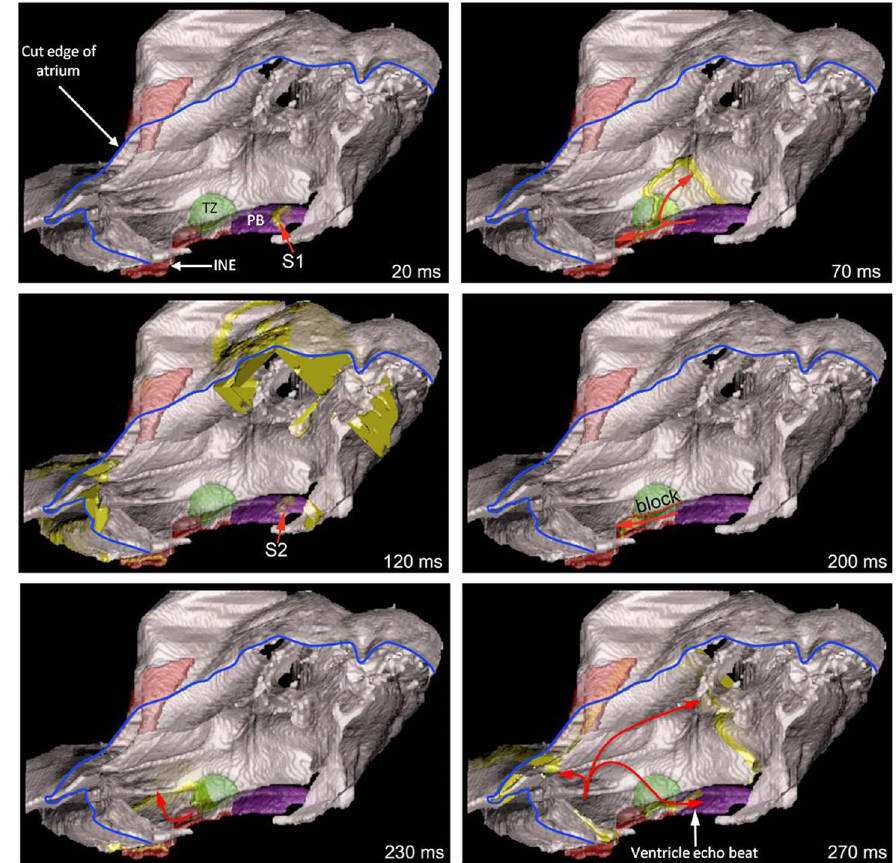
Figure 9. Simulation of a ventricular echo beat. A right view of the model of the right atrium is shown with one face of the right atrium removed (the blue line shows the cut edge of the right atrium). Different segmented structures are shown in different colours. The panels show snapshots of activation after S1–S2 stimulation of the penetrating bundle. The thick yellow lines show the advancing wavefront of activation. The arrows show the direction of action potential conduction. 20 ms, retrograde conduction of the action potential along the penetrating bundle following S1 stimulation. 70 ms, retrograde conduction of the action potential along the fast (transitional zone; green) and slow (inferior nodal extension, red) pathways out of the AVN following S1 stimulation. 120 ms, retrograde conduction of the action potential along the penetrating bundle following S2 stimulation. Note the action potential following S1 stimulation has reached the outer parts of the right atrium. 200 ms, block of conduction along the fast pathway (line of block, red dotted line) and retrograde conduction along the slow pathway following S2 stimulation. 230 ms, retrograde conduction out of the slow pathway and into the right atrium following S2 stimulation. 270 ms, retrograde conduction throughout the right atrium and reentry into the AVN – the action potential conducted anterogradely through the transitional zone to the penetrating bundle. It is this action potential that would result in a ventricular echo beat. INE, inferior nodal extension; PB, penetrating bundle; TZ, transitional